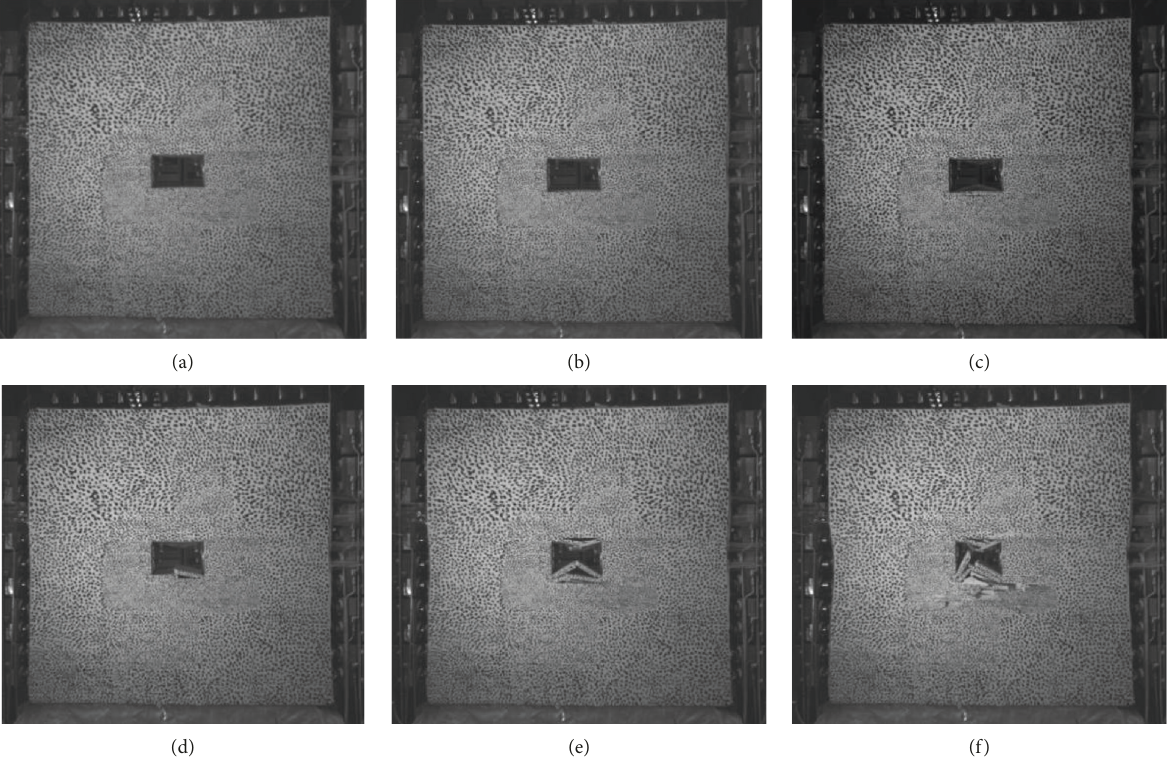
Figure 4: Video screenshot of physical model according to loading scheme and deformation phenomenon; (a) Under load level 4; (b) Under load level 14; and (c–e) Under load level 23 and cumulative duration is 541mins, 542mins, 543mins and 544mins